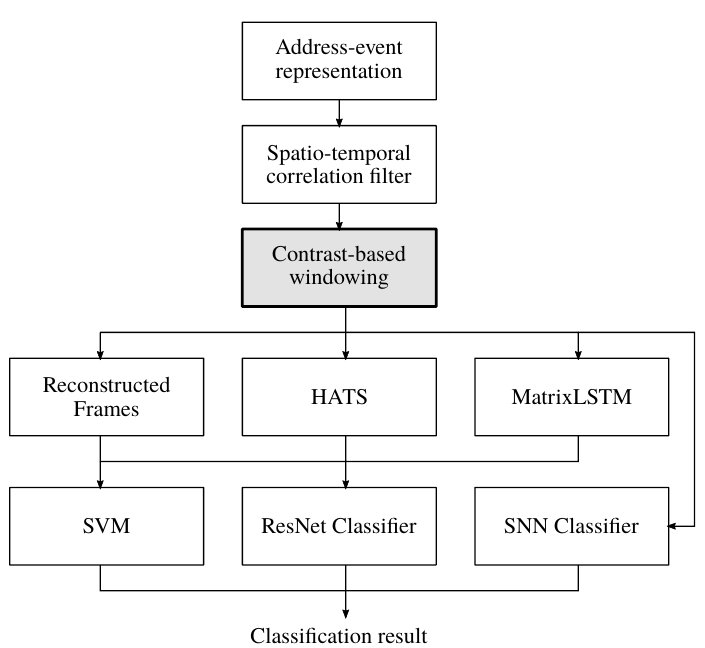
Figure 4. Visual summary of the proposed pipeline including the new CBW